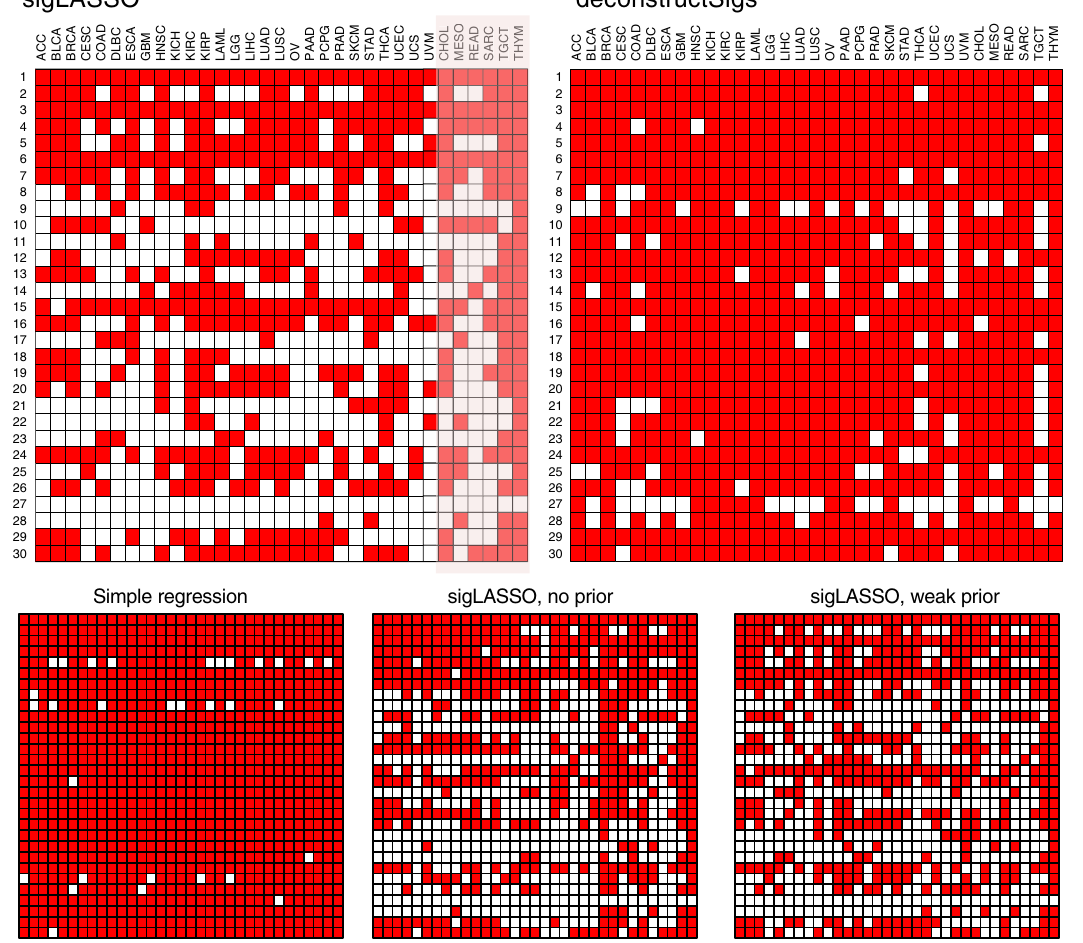
Fig. 4 Performance on 33 TCGA cancers. Active signatures (total contribution >0.1%) in 33 cancer types using different methods. Only 27 cancer types have previously known signature distributions (others are shaded). Penalty coef fi cients of priors used for sigLASSO: 0.01. Weak priors: 0.5. Priors were taken from COSMIC, and provided with our "sigLASSO'' R